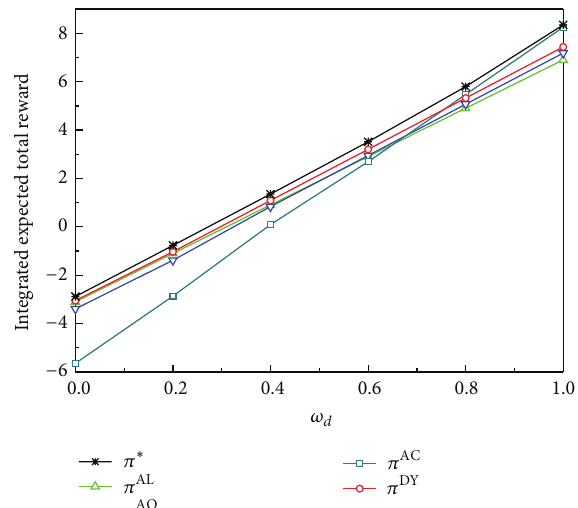
Figure 5: Integrated expected total reward.